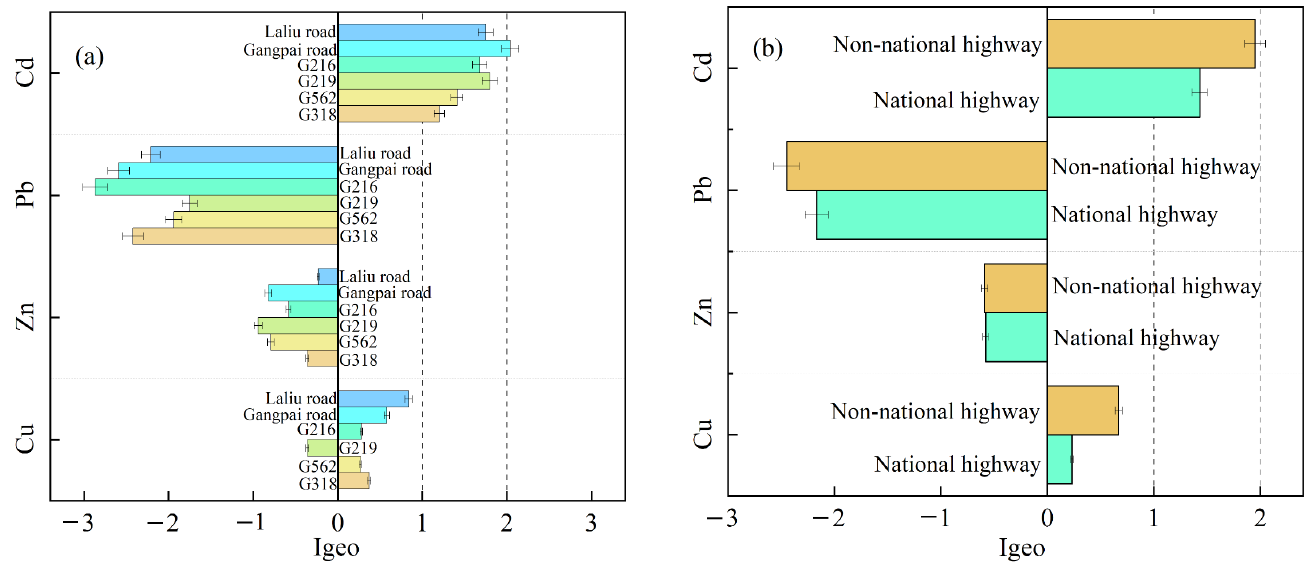
for soil heavy Figure 3. Mean geoaccumulation index for soil heavy metals. ( a ) The mean Figure 3. Mean geoaccumulation index for soil heavy metals. ( a ) The mean I geo for soil heavy metals for soil heavy metals near national and non-na- metals near different roads. ( b ) The mean near different roads. ( b ) The mean I geo for soil heavy metals near national and non-national 𝐼𝐼 𝑔𝑔𝑔𝑔𝑔𝑔 tional highways. 𝐼𝐼 𝑔𝑔𝑔𝑔𝑔𝑔